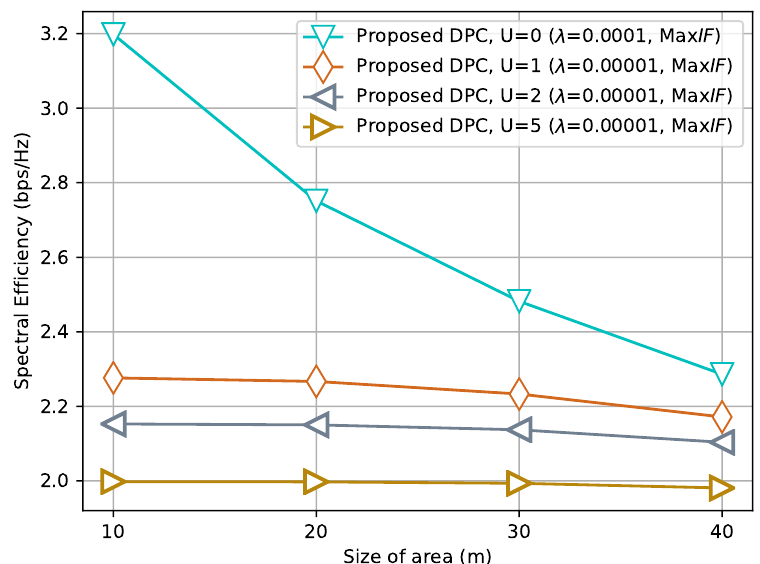
Figure 15. Average spectral efficiency of the proposed scheme for α = 5 in Rayleigh fading channels when the cellular users are out of the D2D communication area.